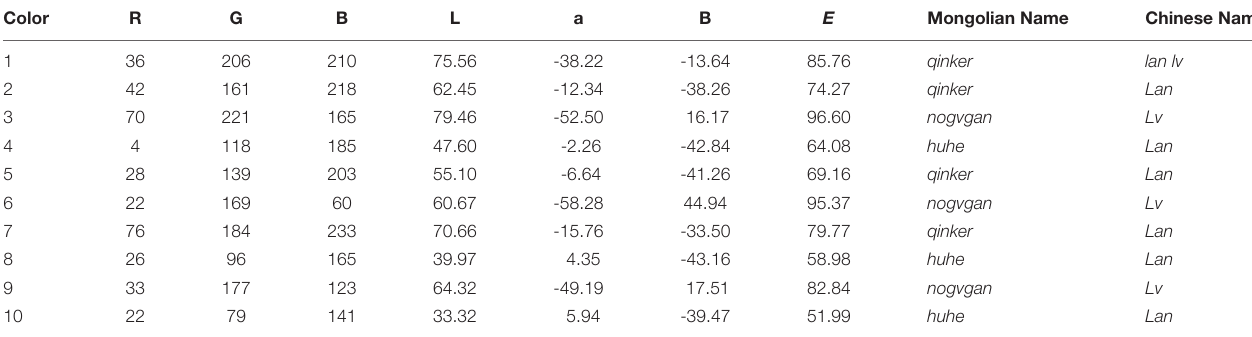
TABLE A1 | CIELAB coordinates of the stimuli crossing the boundary in the free-sorting task.